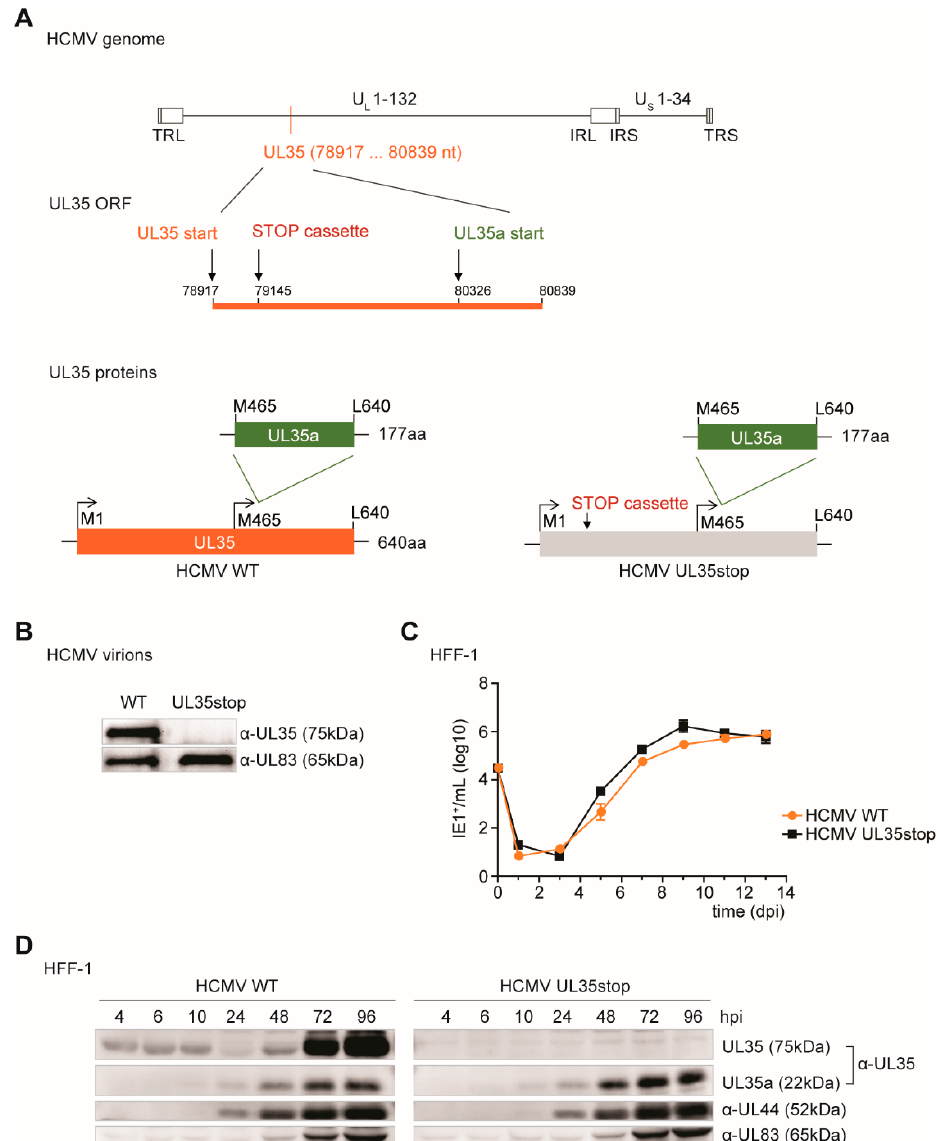
Figure 2. Construction of HCMV UL35stop by en passant mutagenesis. ( A ) Schematic representation of the recombinant HCMV UL35stop generated in this study. The location of the UL35 open reading frame is shown and position of the inserted STOP cassette is depicted. Numbers correspond to nucleotide locations in the genome (HCMV strain TB40/E, GenBank accession # EF999921.1). The scheme shows the translation products from the UL35 ORF of either wildtype (WT left panel) or UL35stop (right panel) HCMV. ( B ) Nycodenz-purified virus of HCMV WT and UL35stop was adjusted to 5 × 10 4 viral particles based on the virus titer and subjected to SDS-PAGE. Immunoblotting was performed with antibodies specific for UL35 and UL83. ( C ) HFF-1 were infected with HCMV WT or UL35stop at an MOI of 0.1 and supernatant was harvested at the indicated time points. Fresh HFF-1 were infected with serial dilutions of the harvested supernatants for 48 h. Cells were then fixed with PFA and immunolabeled with an anti-IE1 antibody. IE1-positive cells were counted and the resulting titer (IE1 + /mL) was log transformed to plot the growth curve. ( D ) HFF-1 were infected with either HCMV WT or UL35stop at an MOI of 0.1 and lysed at the indicated time points post infection. Whole cell lysates were analyzed by immunoblotting with antibodies specific for HCMV proteins UL35, UL44, and UL83. hpi: hours post infection, dpi: days post infection